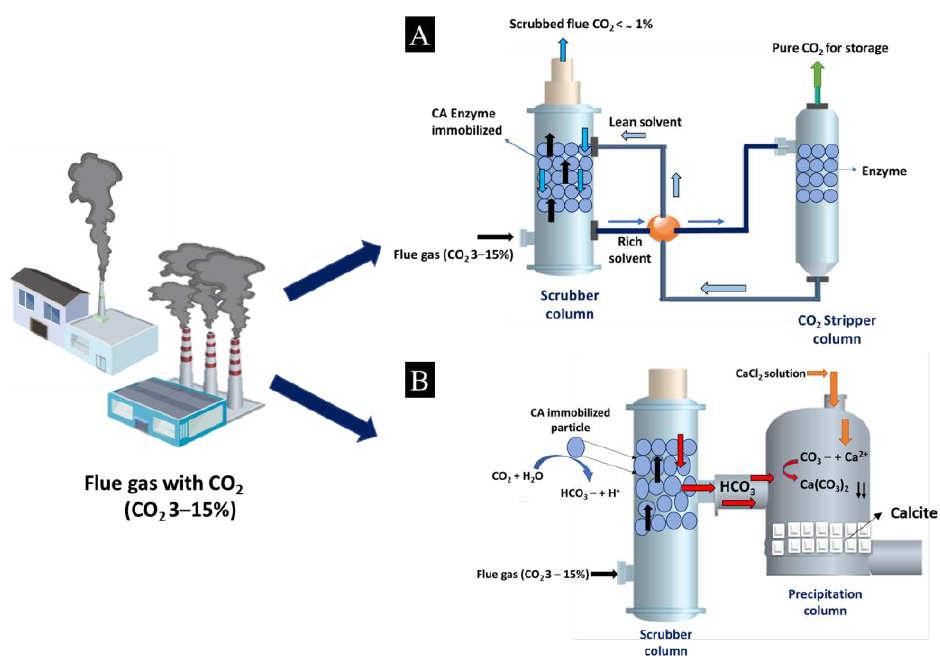
Figure 7. Schematic representation of CO 2 capture, storage and utilization process. ( A ) Represents the CO 2 sequestration process that involves the removal of CO 2 from the flue gas that is in the absorber column and then desorbed in a heated stripper column to attain relatively pure CO 2 . ( B ) Depicts the process of bicarbonate formation. The immobilized CA (scrubber column) absorbed the released CO 2 , and the precipitation column ’ s carbonate ions were transformed into the compound CaCO 3 in the presence of a CaCl 2 solution. Reproduced with permission from Kanth et al. [97] Copyright 2013 Wiley.